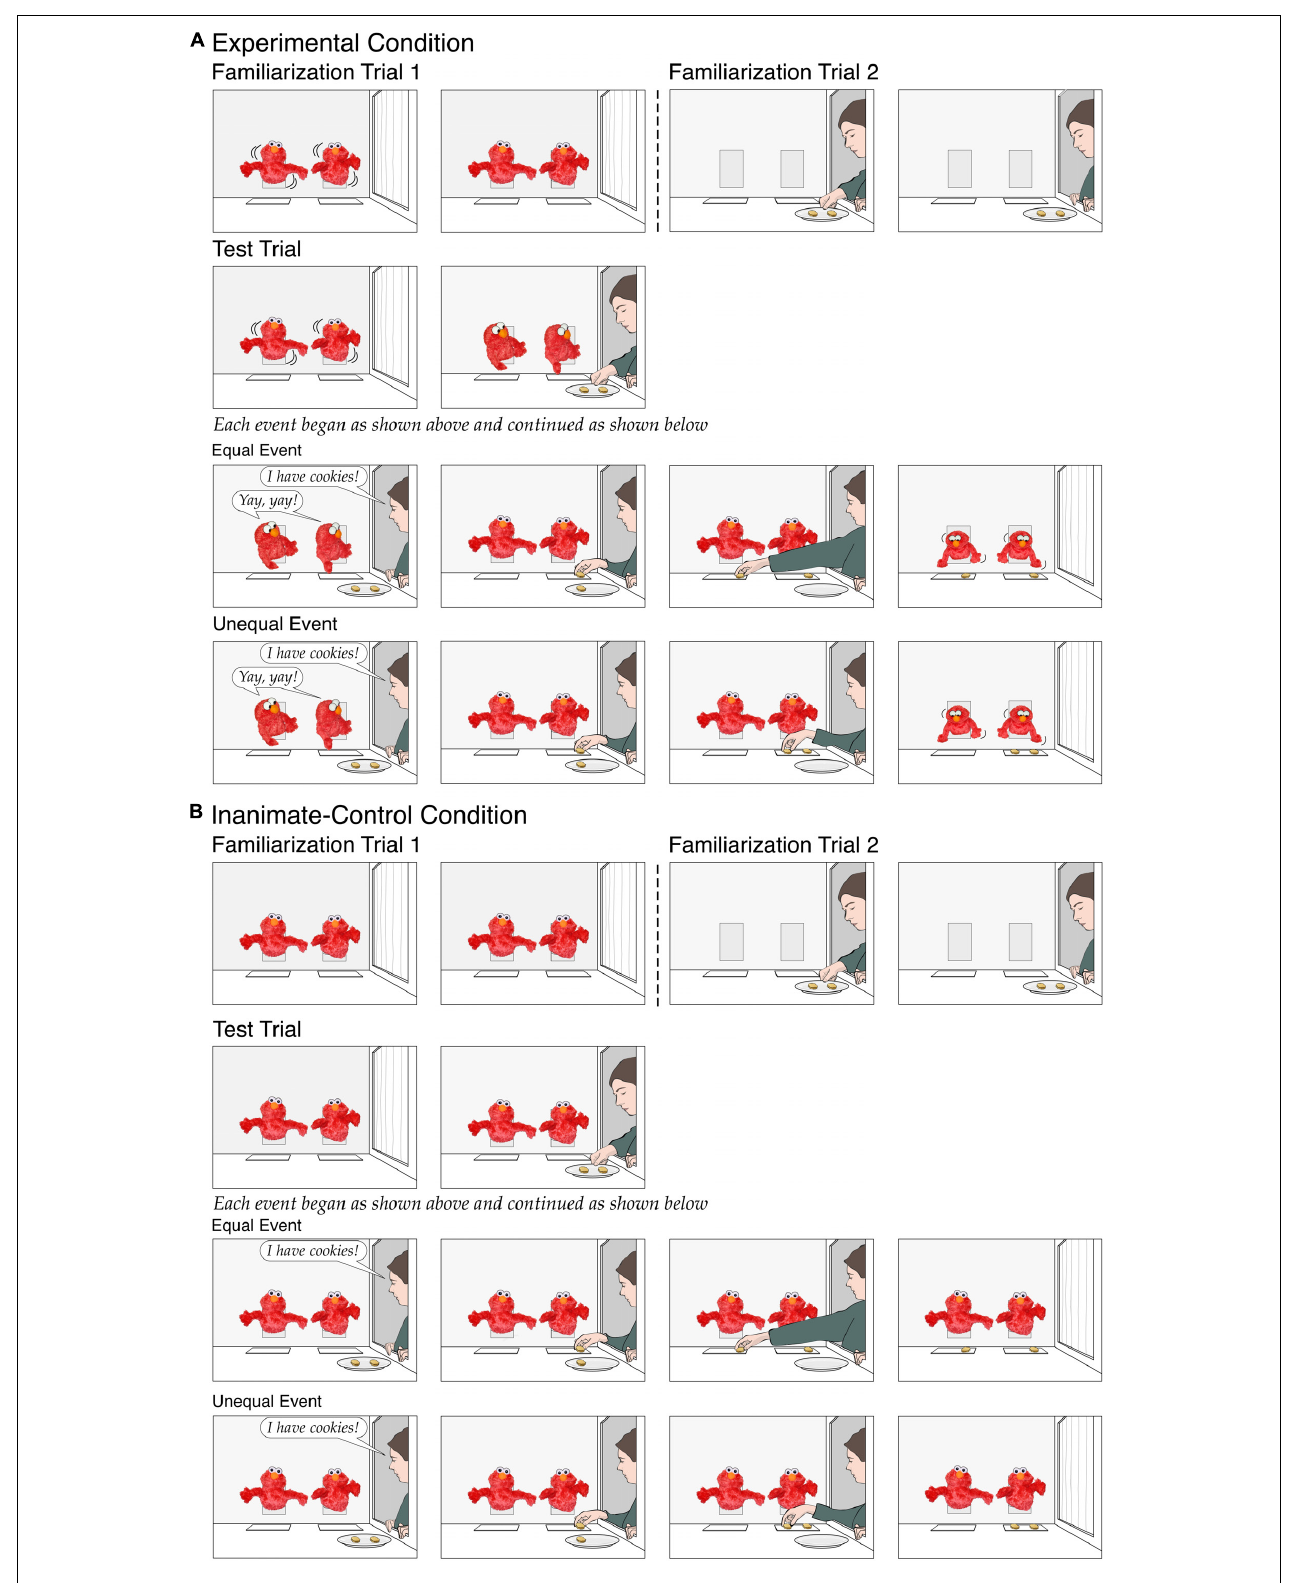
FIGURE 5 | Schematic depiction of the events shown in the experimental condition (A) and the inanimate-control condition (B) of Experiment 4.